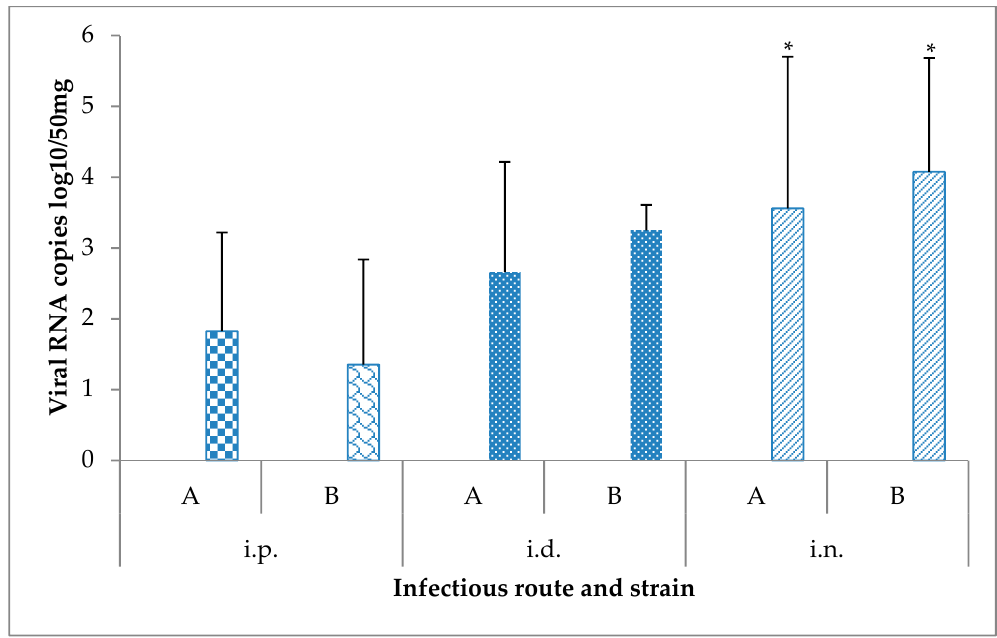
Figure 3. Viral RNA loads measured by RT-qPCR in brain samples ( n = 6 per condition) collected from mice 15 days after their challenge with the Usutu virus via different routes. * p- value < 0.05. A: USU-BE-Seraing / 2017, B: USU-BE-Grivegnee / 2017, i.d.: intradermal, i.n.: intranasal, i.p.: intraperitoneal.